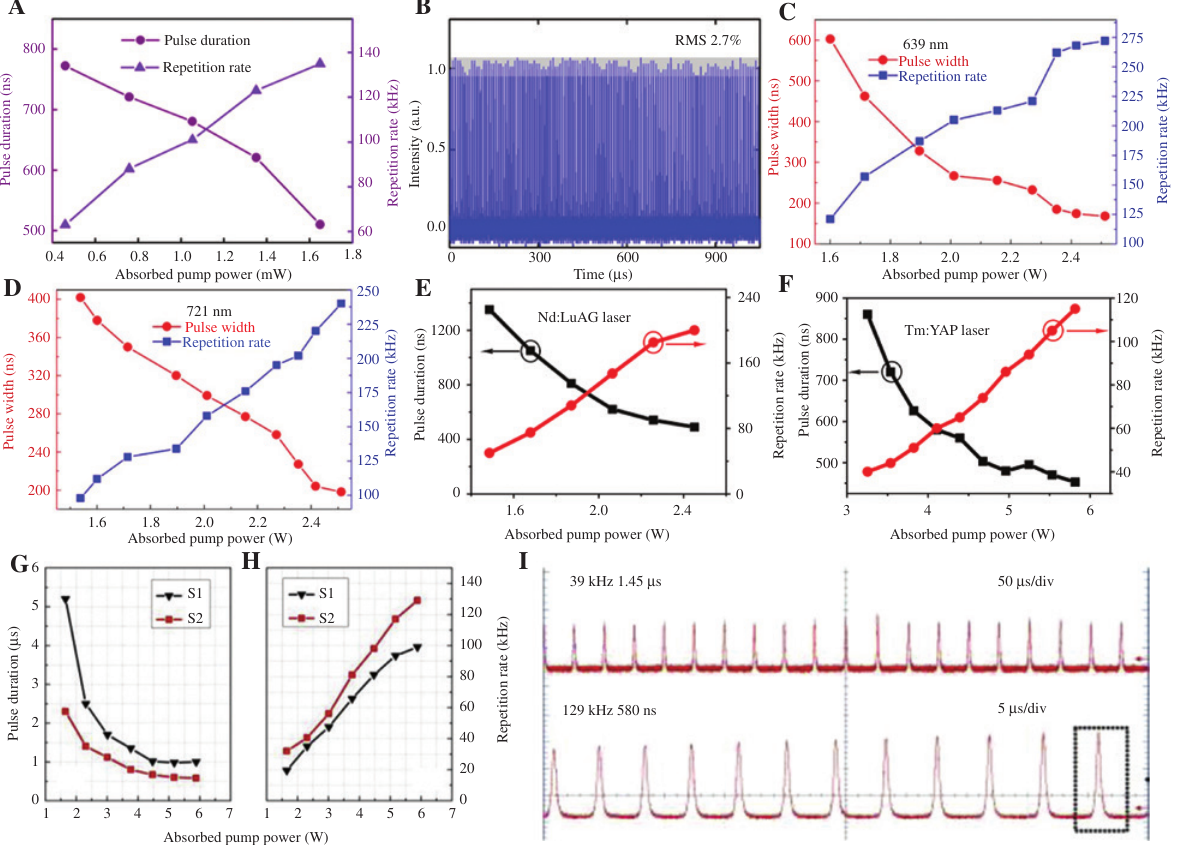
Figure 6: BiQDs, GNSs, and SiNPs Q-switched lasers. (A) Pulse duration and repetition rate vs. absorbed pump power, (B) pulses trains of BiQDs Q-switched laser. Reproduced with permission [79]. Copyright 2019, Optical Society of America. Pulse width and repetition rate vs. absorbed pump power of the GNSs Q-switched lasers at (C) 721-nm and (D) 639-nm region. Reproduced with permission [80]. Copyright 2019, Optical Society of America. Pulse durations and repetition rates for SiNPs Q-switched (E) Nd:LuAG laser and (F) Tm:YAP laser. Reproduced with permission [78]. Copyright 2018, Optical Society of America. The dependence of (G) pulse duration and (H) repetition rate on absorbed pump power, (I) pulses trains of GNPs Q-switched laser. Reproduced with permission [77]. Copyright 2018,